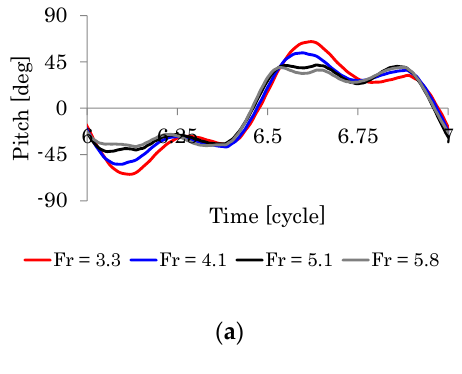
Figure 9. Time histories of ( a ) the pitching angular displacement, and ( b ) the nondimensional lift for the various frequency ratios.